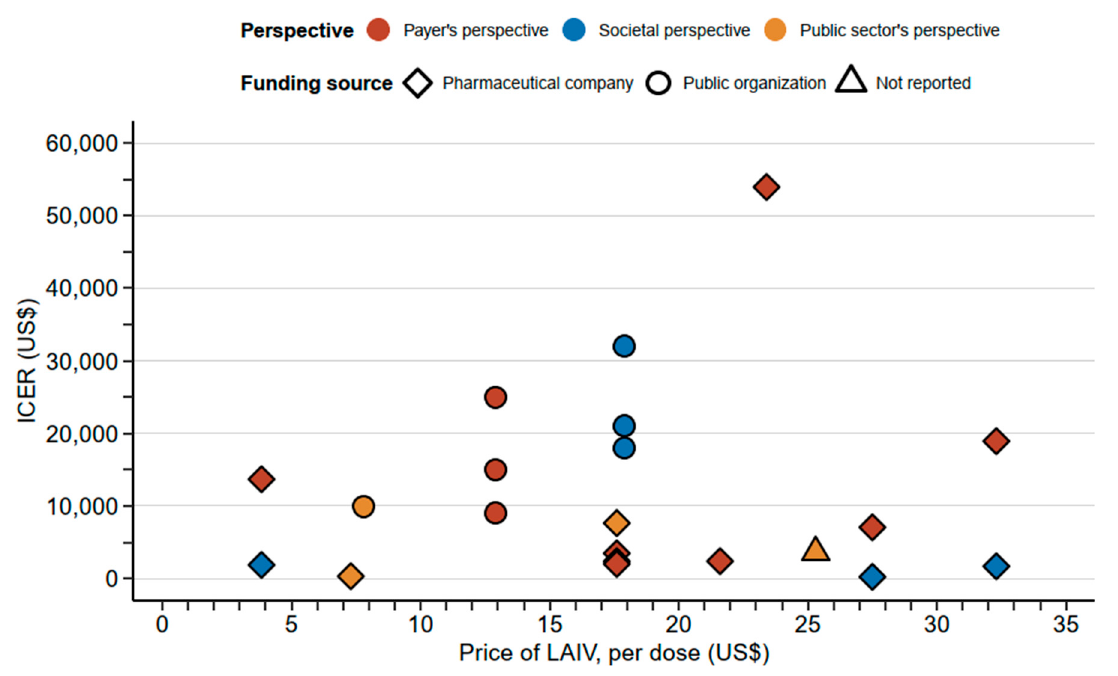
Figure 2. Incremental cost-effectiveness ratios against vaccine prices. Abbreviations: ICER—increment cost-effectiveness ratio; LAIV—live-attenuated influenza vaccine.